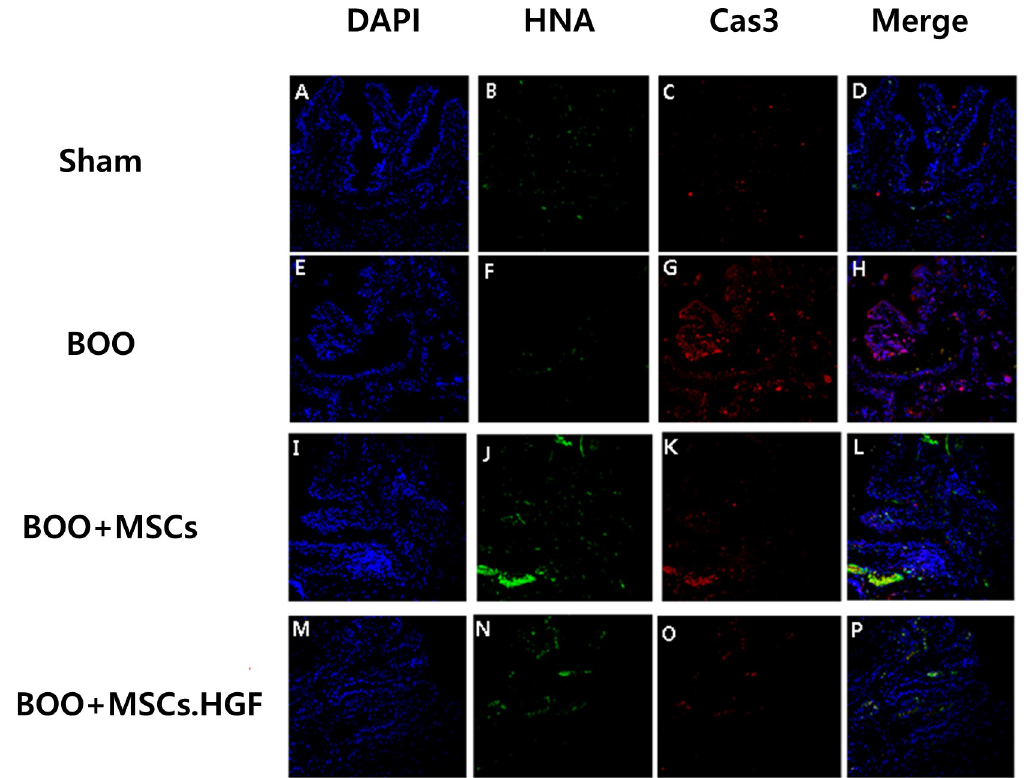
by hMSCs.HGF. A-D. Sham operation group. E-H. BOO group. I-L. transplantation of hMSCs after BOO. M-P. hMSCs.HGF transplantation after BOO. DAPI = 4’,6-diamidino-2-phenylindole, HNA = human nuclear antigen, Cas3 = caspase 3. Sham = sham operation, BOO = bladder outlet obstruction, hMSCs = human mesenchymal stem cells, hMSCs.HGF = HGF overexpressing human mesenchymal stem